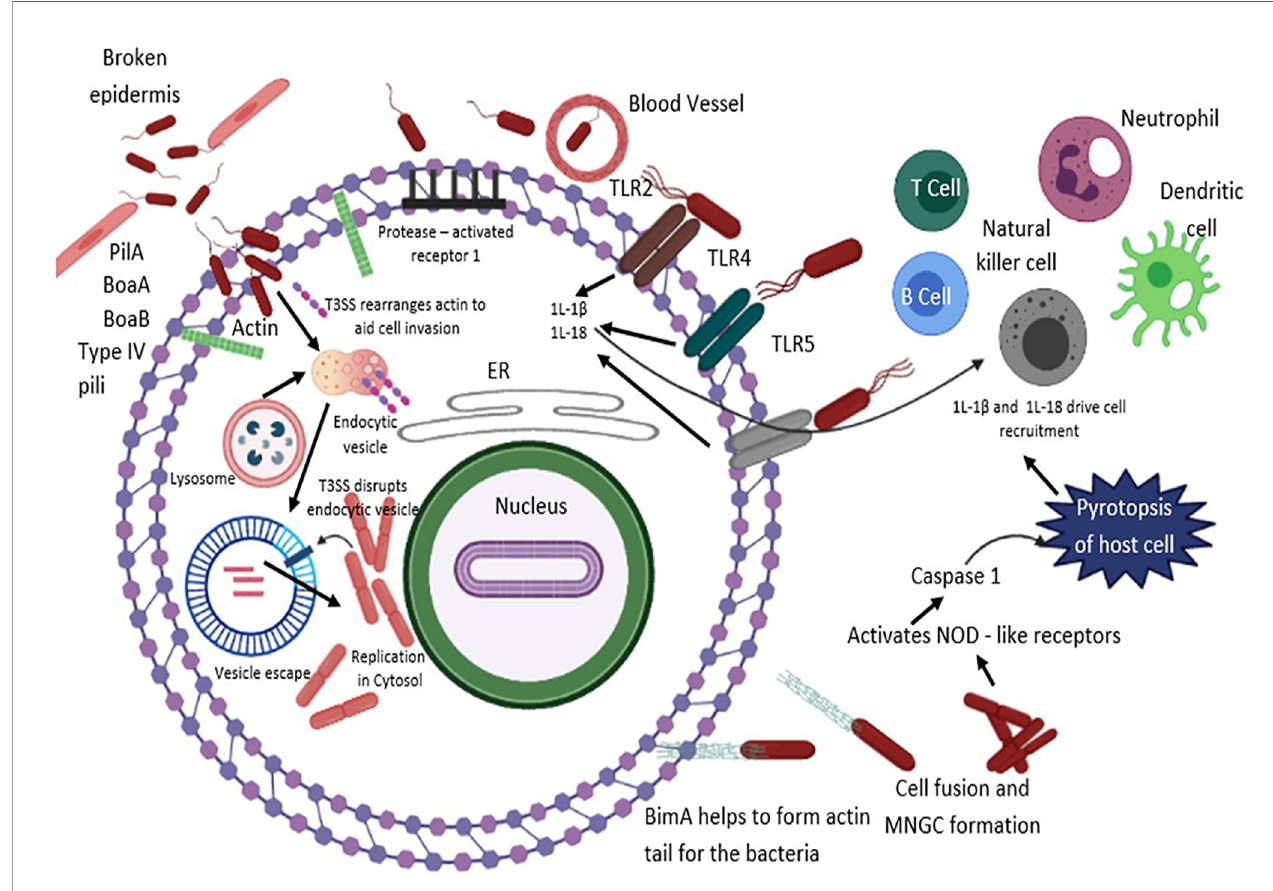
FIGURE 2 | B. pseudomallei secretes N-acyl-homoserine lactone (AHL) signalling molecules that are implicated in coordinating attacks in contradiction of the host environment and bio fi lm formation. The T3SS effector proteins are vital for invasion and escape from host endosomal vesicle. Host cell entry is assisted by fl agella, lipopolysaccharide (LPS), type IV pili and adhesion molecules. B. pseudomallei evades the vesicle and lyses the endosomal membrane using T3SS, T6SS and T2SS. Production of cationic peptides and ecotins facilitate B. pseudomallei to survive within an acidic endosomal environment. BopA (an effector protein) and BipD (translocator protein) obstruct sequestration in endosomal vesicles and avert microtubule-associated protein mediated autophagy. Upon entry into the cytoplasm compartment, B. pseudomallei replicates, and initiates the development of actin-based membrane protrusions and can pass through constant polymerization of host cell actin, thus accelerating dissemination to neighboring cells causing cell fusion and multinuclear giant cell (MNGC) formation. TLRs positioned on cell surfaces engage with the PAMPs and mediate NF- k B-induced initiation of immune responses, releasing pro-in fl ammatory cytokines IL-1 b and IL-18 and facilitate caspase-1- mediated pyroptosis. Additionally, IL-18 warrants defensive IFN g production, which allows recruitment of neutrophils, dendritic cells, B cells and T cells to the infection site, eventually activating the complement and coagulation